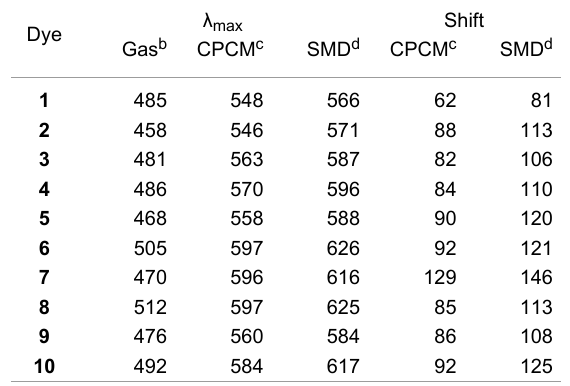
Table 1: Calculated λ max values and the shift resulting from the different solvent models. a